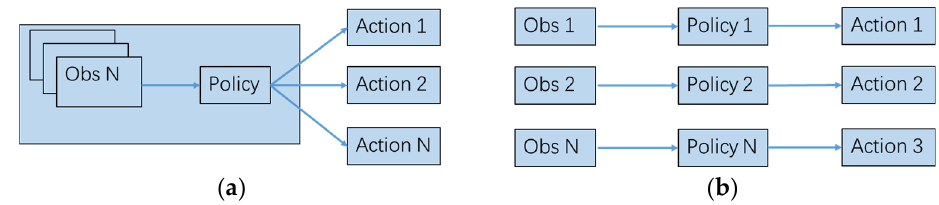
Figure 8. Centralized and independent strategies. ( a ) represents a centralized strategy, and ( b ) represents an independent strategy, which can realize distributed control without communication.